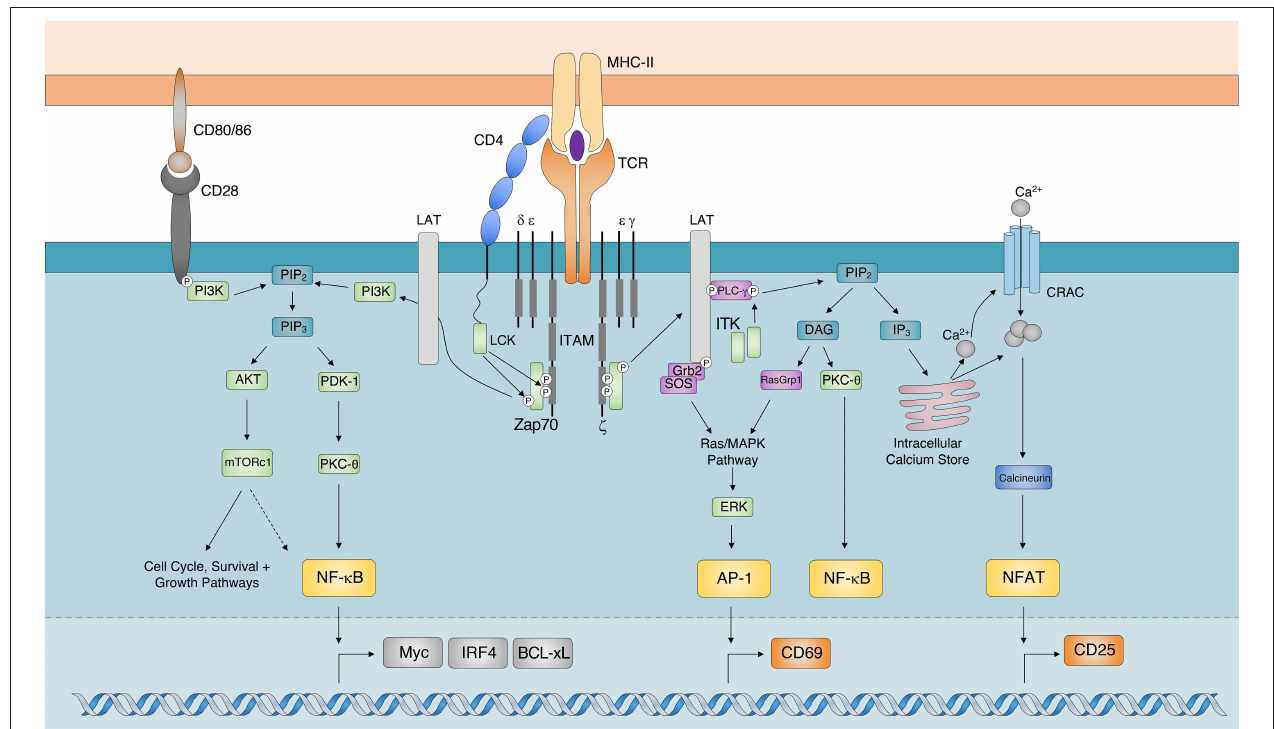
FIGURE 1 | TCR Signaling Cascade. The major signaling components and transcription factors responsible for the transduction of TCR signals following the recognition of cognate pMHC-II. While AKT dependent activation of mTOR signaling regulates cell proliferation, survival, and growth pathways it has also been shown to regulate the expression of Myc, IRF4, and BCL-xL by potentially regulating (indicated by dashed arrow) the activity of NF- κ B. AP-1, Activator Protein 1; AKT, Protein Kinase B; BCL-xL, B Cell Lymphoma-extra Large; DAG, Diacylglycerol; CRAC, Calcium Release Activated Channel; ERK, Extracellular signal-Regulated Kinase; GRB2, Growth factor Receptor-Bound protein 2; IP 3 , Inositol-1,4,5-trisphosphate; ITAM, Immunoreceptor Tyrosine-based Activation Motif; IRF4, Interferon Regulatory Factor 4; ITK, Interleukin-2-inducible T cell kinase; mTORc1. Mechanistic Target Of Rapamycin complex 1; NFAT, Nuclear Factor of Activated T cells; NF- κ B, Nuclear Factor kappa-light-chain-enhancer of activated B cells; PLC- γ , Phospholipase C-gamma; PDK-1, Phosphoinositide dependent kinase-1; PKC- θ , Protein Kinase C theta; PIP 2 , Phosphatidylinositol-4,5-bisphosphate; RASgrp1, RAS guanyl-releasing protein 1; TCR, T cell Receptor; SOS, Son of Sevenless; Zap70 ζ -chain associated protein kinase of 70